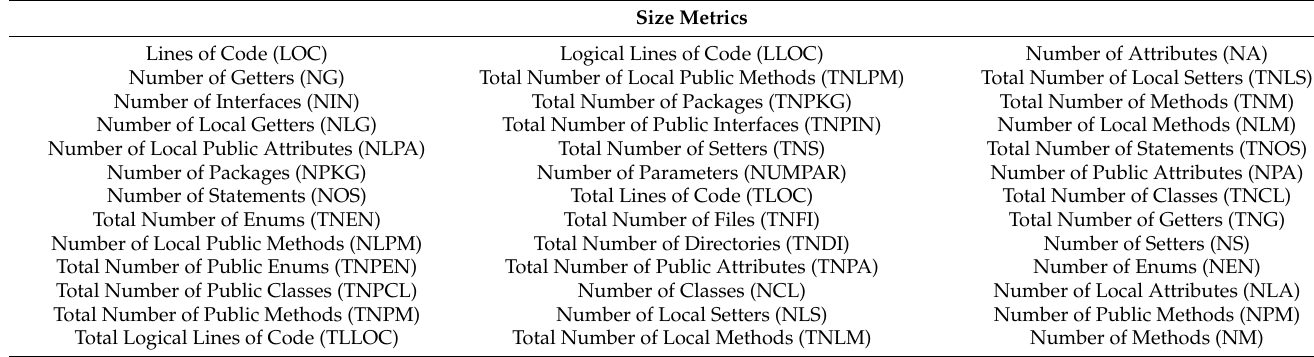
Table 1. Static Size Metrics that were extracted using the Open Static Analyzer.